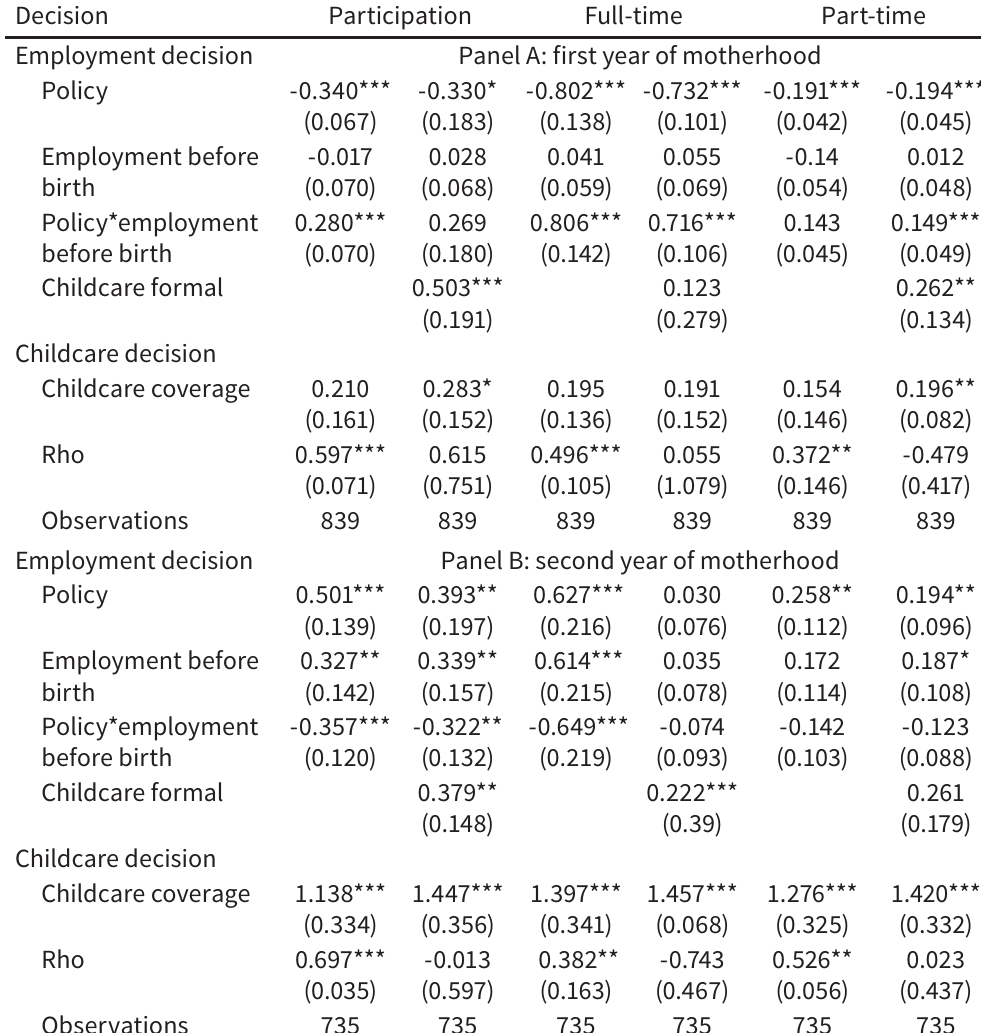
Average marginal effects for maternal childcare decision: high-income category Decision Participation Full-time Part-time Panel A: first year of